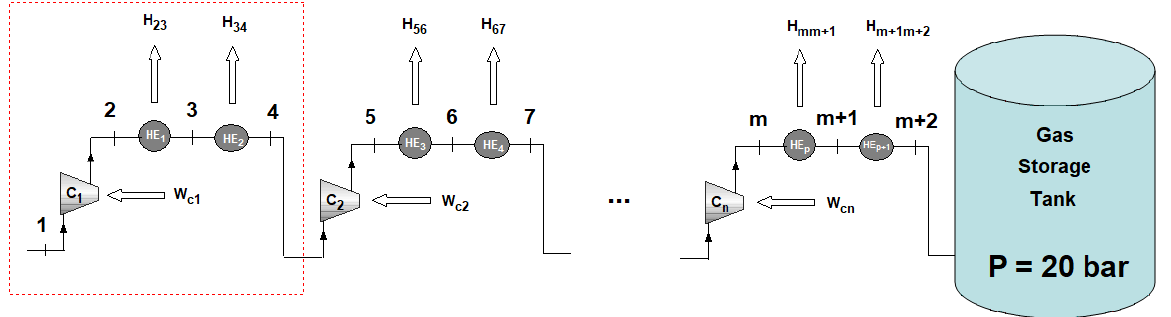
Figure 1. General scheme of the simulation.